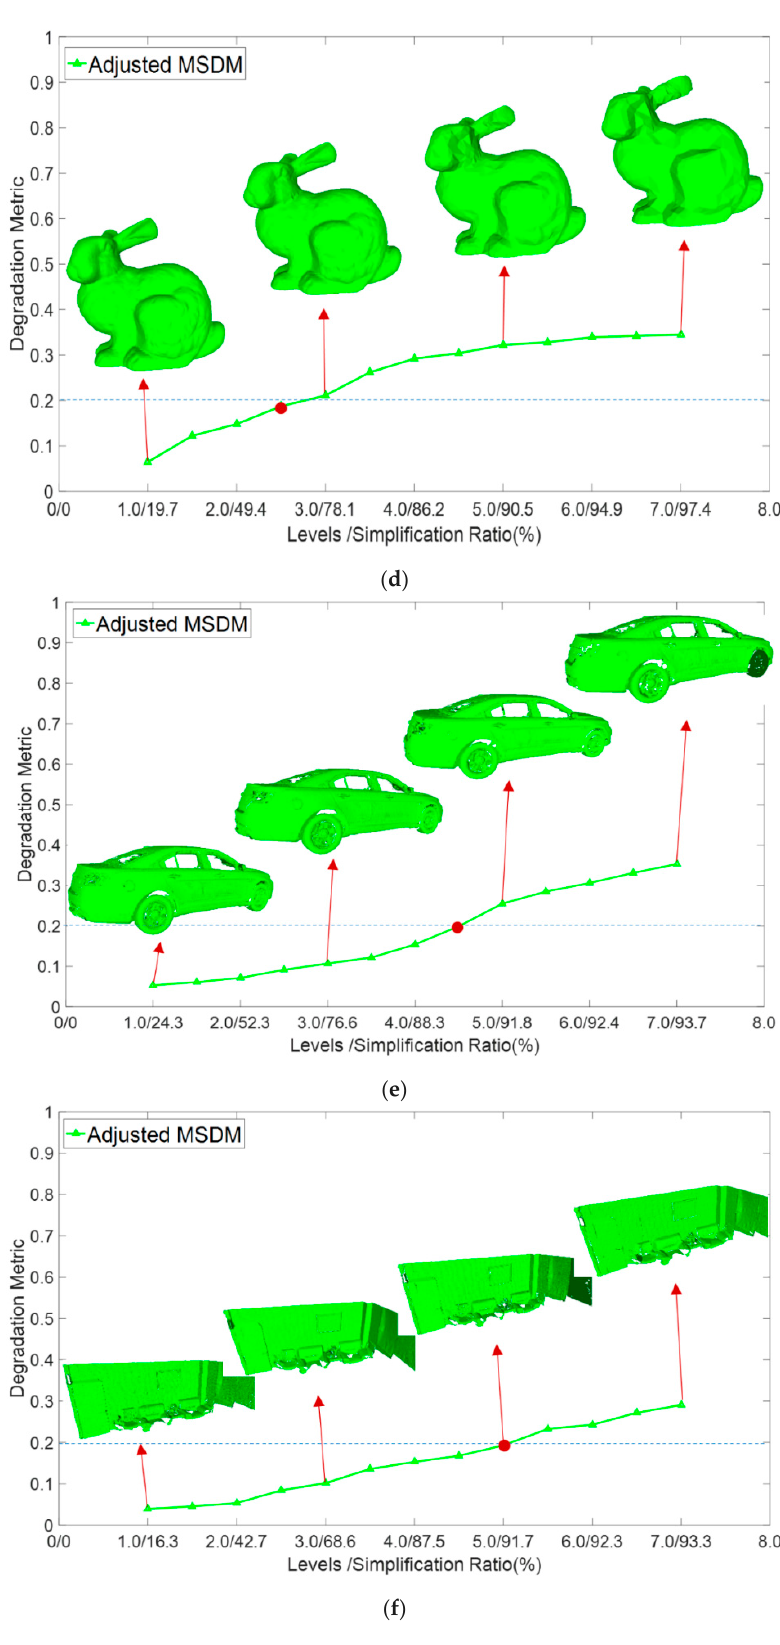
Figure 16. Optimal level selection results. ( a ) Bodhisattva data’s level selection, ( b ) Ananda data’s level selection, ( c ) General data’s level selection, ( d ) Rabbit data’s level selection, ( e ) Car data’s level selection, ( f ) Indoor data’s level selection.